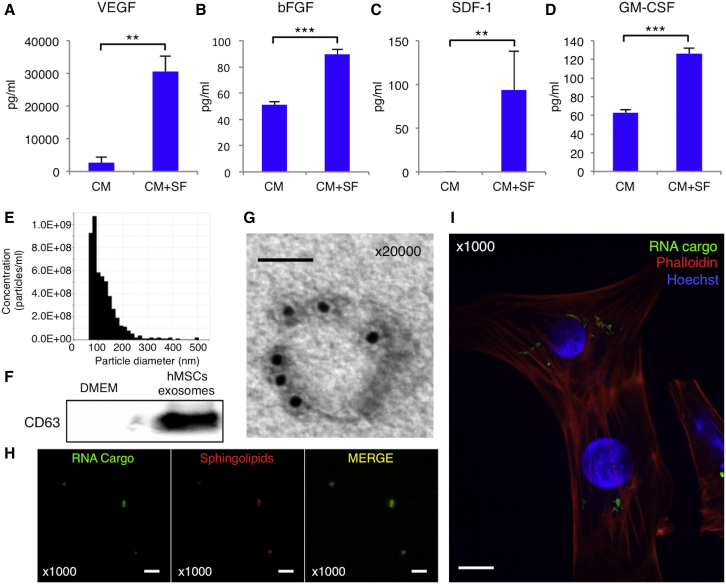
Soluble Factors Derived from hMSCs(A–D) Concentration of vascular endothelial growth factor (VEGF) (A), basic fibroblast growth factor (bFGF) (B), stromal cell-derived factor (SDF-1) (C), and granulocyte-macrophage colony-stimulating factor (GM-CSF) (D) in differentiated cardiomyocytes (CM) and cardiomyocytes cultured with MSC-derived soluble factors (CM+SF; n = 8 for each group). **p < 0.01; ***p < 0.001, Student t test. (E) Distribution of particle size after ultracentrifugation of media with cultured hMSCs using the qNano system. (F) Representative western blotting data of the exosomes of hMSCs using anti-CD63 antibody. (G) Transmission electron microscopy images of an exosome derived from hMSCs stained with anti-CD63 antibody. Scale bar: 50 nm. (H) RNA (stained green, left) and sphingolipids (stained red, middle) are shown; particles containing both (right) RNA and sphingolipids were considered to be exosomes derived from hMSCs. Scale bars, 2 μm. (I) Exosomes derived from hMSCs stained with RNA cargo (green) were incubated with hiPSC-CMs stained with phalloidin (red) and nuclei (Hoechst33258; blue) 12 hr after addition of the exosomes into the culture media. Scale bar, 10 μm. For all experiments, results are shown as mean + SEM.